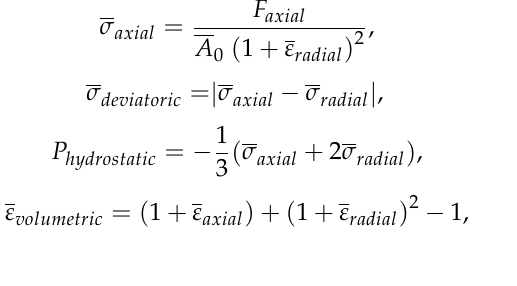
Figure 5. Numerical simulation results of 1 GPa internal pressure applied at five different heights. Ratio of the internal radial stress to the external hoop strain at z = 0.